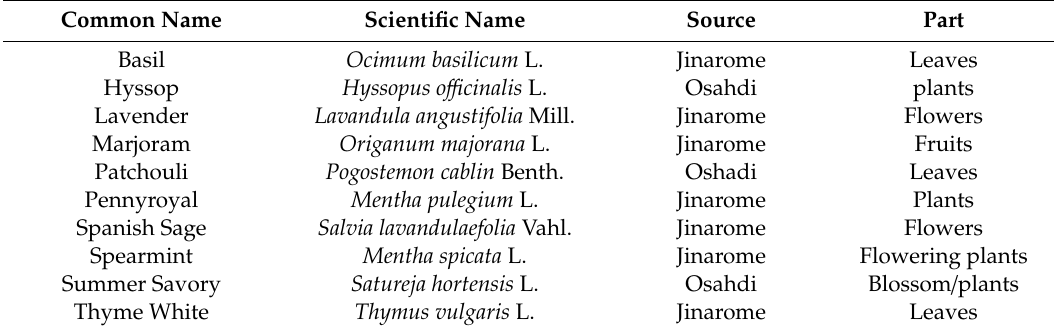
Table 1. List of Lamiaceae plant essential